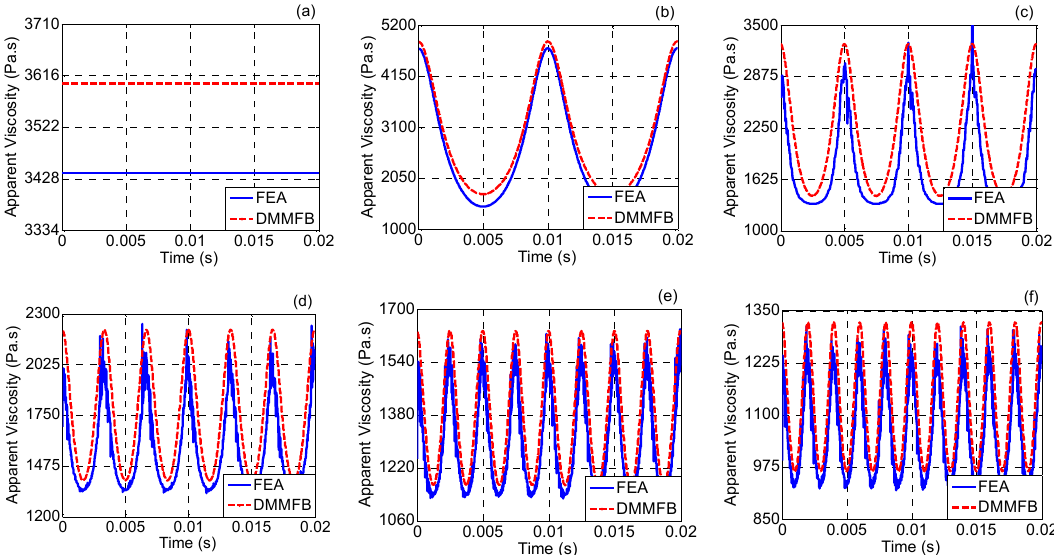
Figure 12. The apparent viscosity of the melt inside the extrusion liquefier without and with 0.25 g vibration applied at different frequencies. ( a ) No vibration applied, ( b ) 100 Hz, ( c ) 200 Hz, ( d ) 300 Hz, ( e ) 400 Hz, ( f ) 500 Hz.